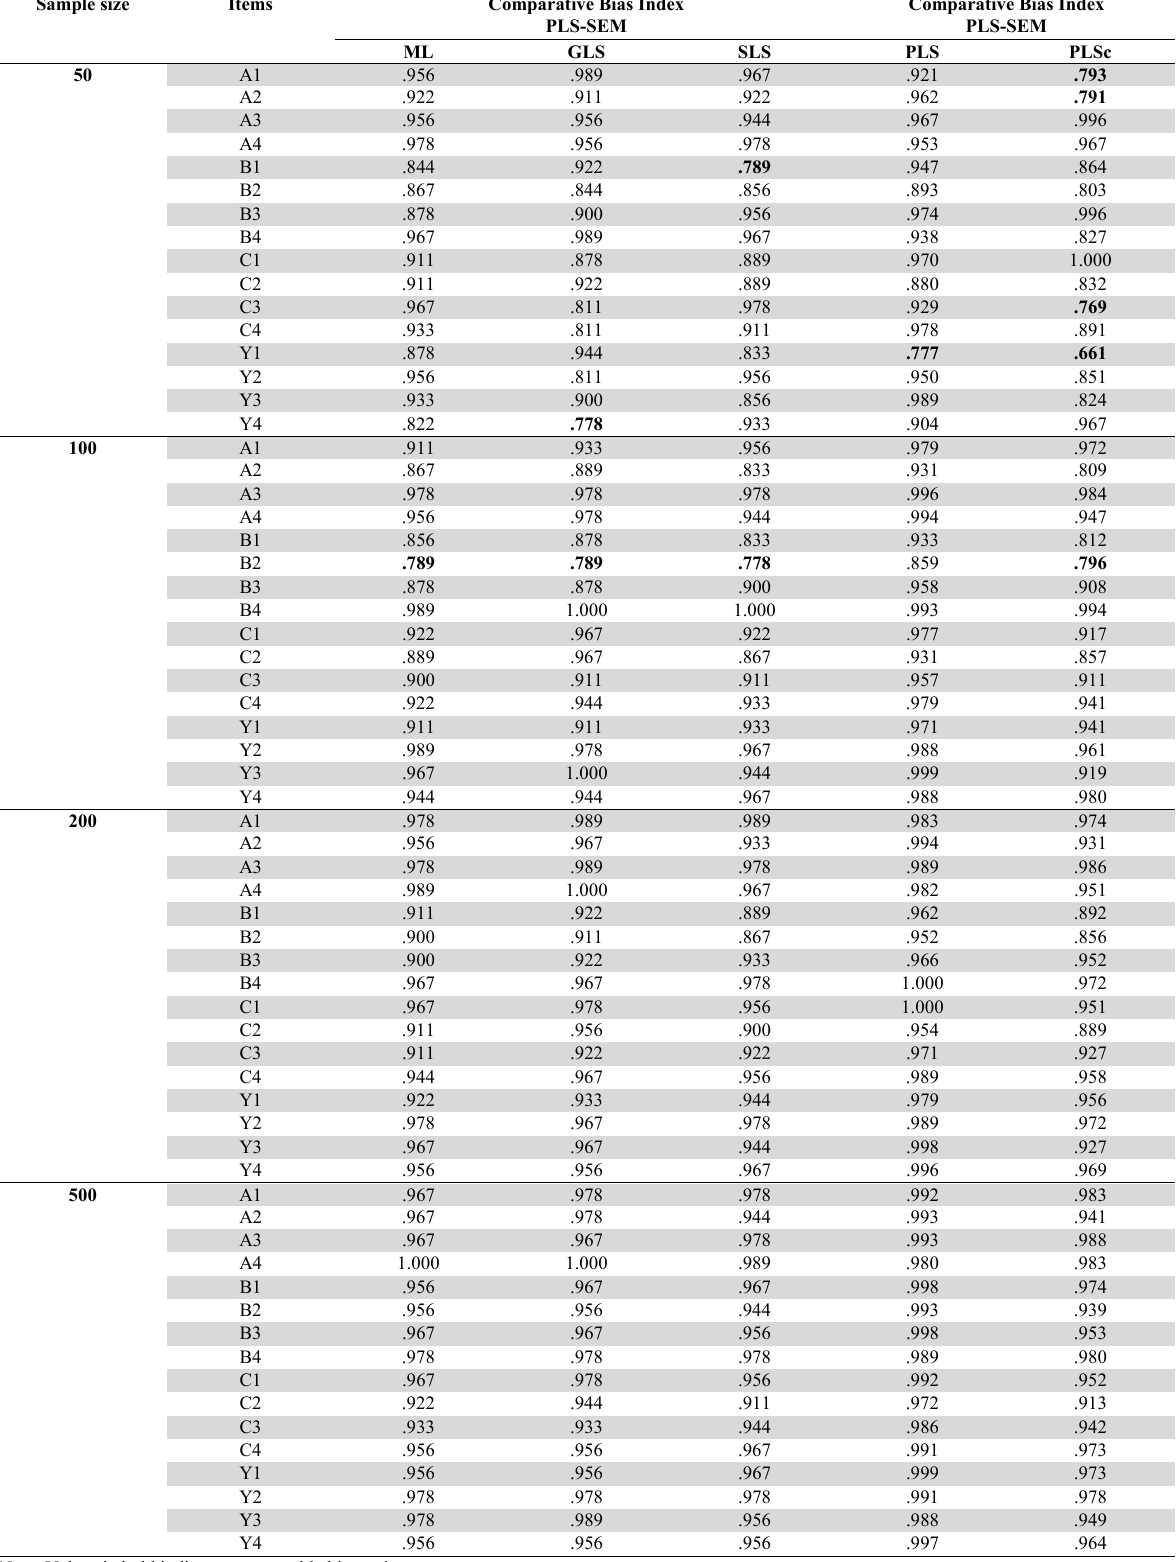
Table 3 The Comparative Bias Index (CBI) - Model 3 Sample